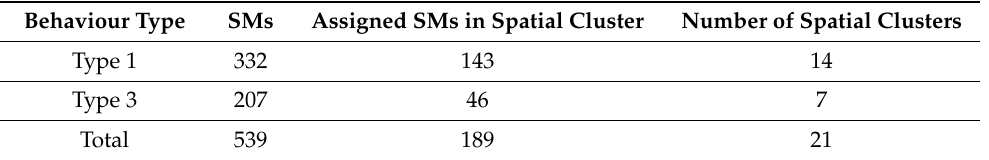
Table 5. Number of spatial clusters found for each type of behaviour and number of SMs that were grouped into spatial clusters.